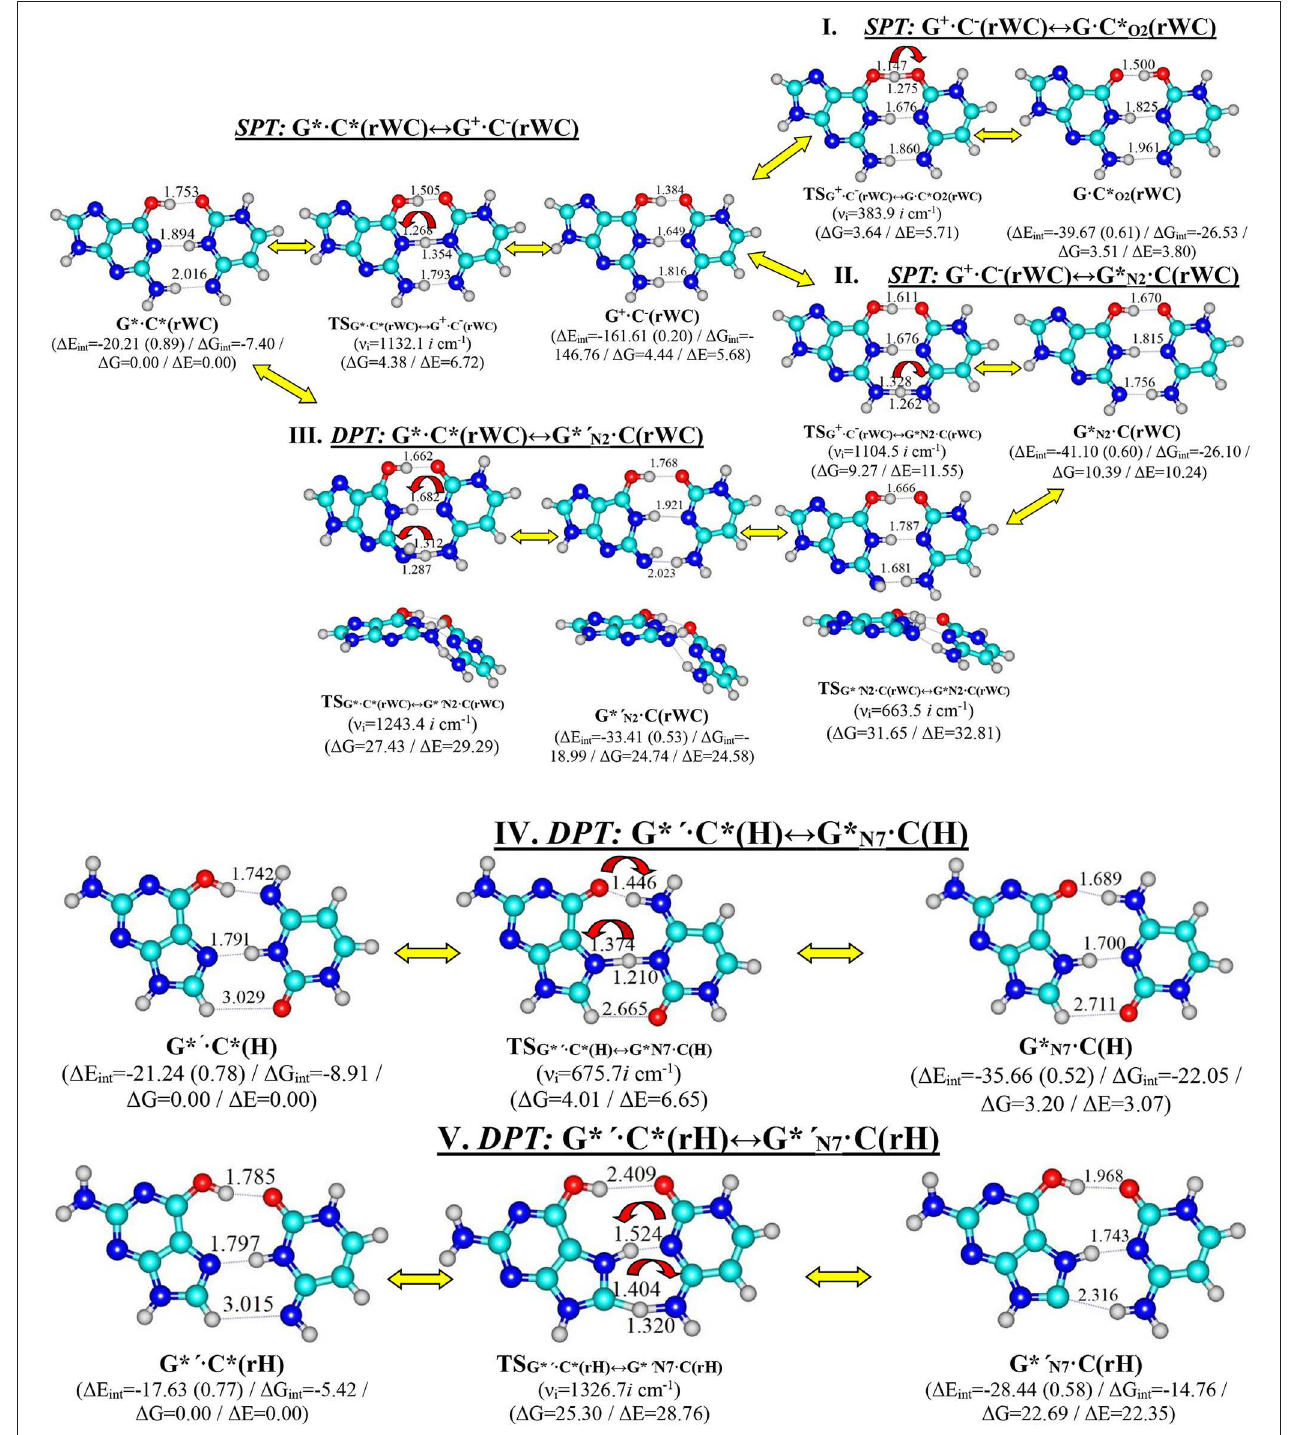
FIGURE 1 | Discovered new reaction pathways of the tautomerization in the reverse Watson-Crick G* C*(rWC) – I. G* C*(rWC) G + C − (rWC) G C* O2 (rWC), II. · · ↔ · ↔ · C(rWC), Hoogsteen G* ′ C*(H) – IV. G* ′ C*(H) G* N7 C(H)—and reverse Hoogsteen G* ′ C*(rH) – V. G* C*(rWC) G + C − (rWC) G* N2 C(rWC), III. G* C*(rWC) G* ′ N2 · · · ↔ · · · ↔ · ↔ · · ↔ C(rH) – DNA base pairs through the single or double proton transfer. Electronic 1 E int and Gibbs free 1 G int energies of the interaction G* ′ C*(rH) G* ′ N7 · · ↔ [MP2/6-311 G(2df,pd)//B3LYP/6-311 G(d,p) level of theory, in kcal mol − 1 ], relative Gibbs free energies 1 G, and electronic energies 1 E ++ ++ · [MP2/aug-cc-pVDZ//B3LYP/6-311 G(d,p) level of theory in the continuum with ε 1 at T 298.15 in kcal mol − 1 ] are presented below complexes in brackets. ++ = = · Dotted lines indicate AH B H-bonds – their lengths H B are presented in angstroms; carbon atoms are in light-blue, nitrogen—in dark-blue, hydrogen—in gray and ··· ··· oxygen – in red. ν i —imaginary frequencies at the TSs of the tautomeric/conformational